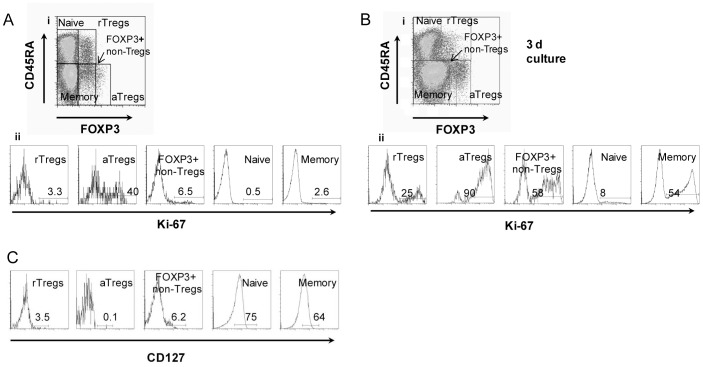
Identification of rTregs, aTregs, and FOXP3+ non-Tregs in healthy donors by flow cytometry. Ai.Based on the expression of CD45RA and FOXP3, five subsets of CD4+T cells are defined: FOXP3lowCD45RA+ (rTregs), FOXP3highCD45RA- (aTregs), FOXP3lowCD45RA- (FOXP3+ non-Tregs), FOXP3-CD45RA+ (naive T cells) and FOXP3-CD45RA- (memory T cells). Representative dot plots of CD45RA and FOXP3 expression on CD4+ T cells performed on PBMCs (n = 27) Aii. Representative histograms showing the expression of the proliferation marker Ki-67 for each cellular population defined in Ai. Bi. Representative dot plot of CD45RA and FOXP3 expression on CD4+ T cells performed on PBMCs activated during three days by using anti-CD3/CD28 antibodies. Bii. Representative histograms showing the expression of the proliferation marker Ki-67 for each cell population, after activation during three days with anti-CD3/CD28 antibodies. C. Histograms showing the expression of CD127 for each cellular subset. Aii, Bi, Bii, and C: data are representative of six independent experiments.